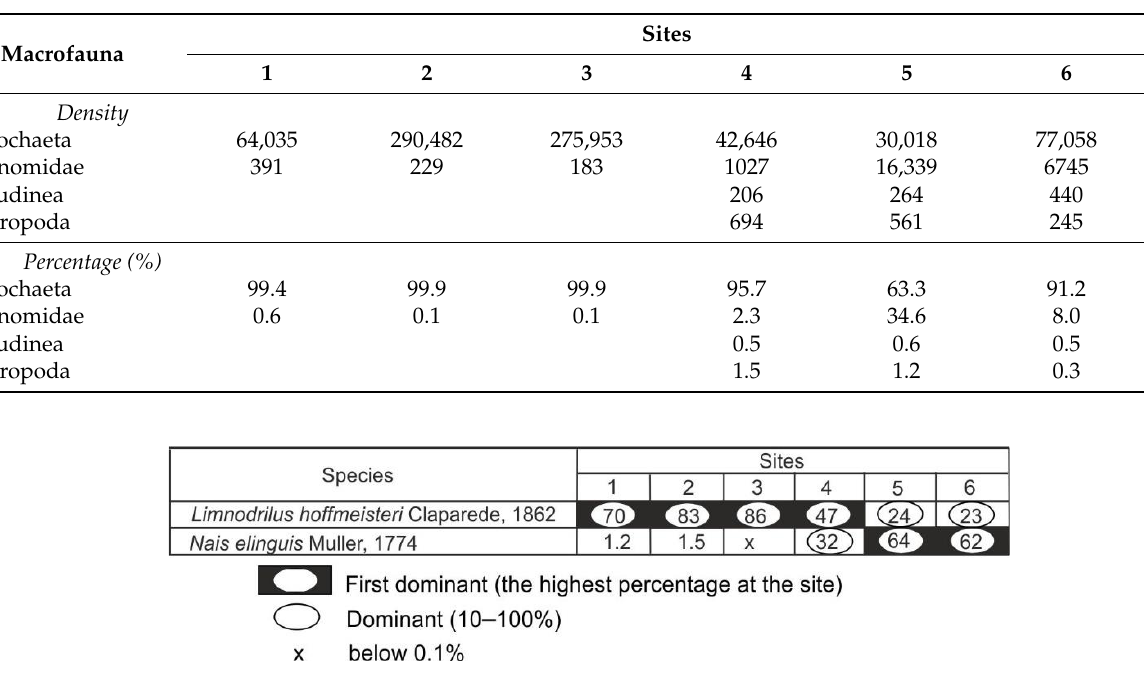
Table 3. Density (individual/m 2 ) of benthic macroinvertebrate groups and their percentage in the Vistula River in 1982–1983 (according to [27]).